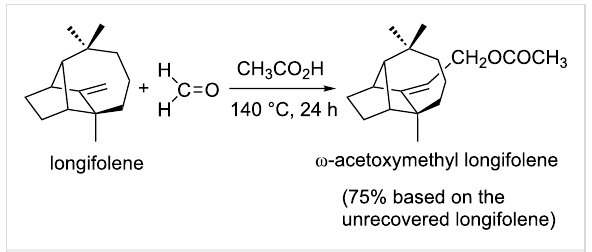
Scheme 4: Formation of the acetate of an allylic alcohol by Prins reac- tion [5].